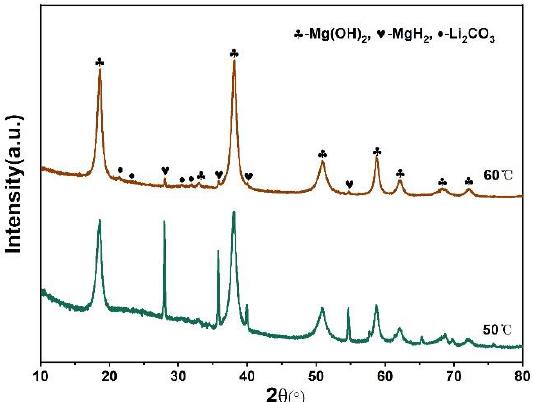
Figure 9. XRD patterns of the hydrolysis byproducts of MgH 2 -3 wt % LiH-BM in deionized water at different bath